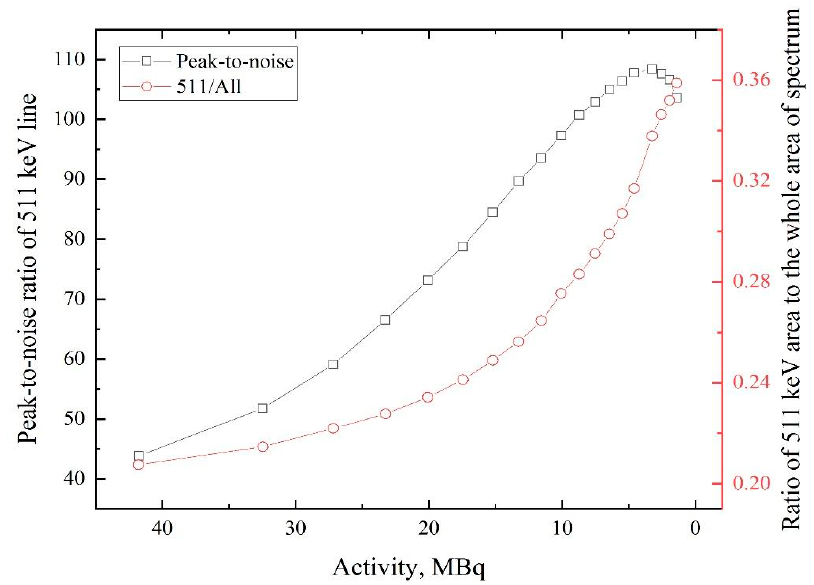
Figure 6. Dependences of 511 keV line peak-to-noise ratio and the ratio area under the line to the area of the whole spectrum on 64 Cu isotope activity.